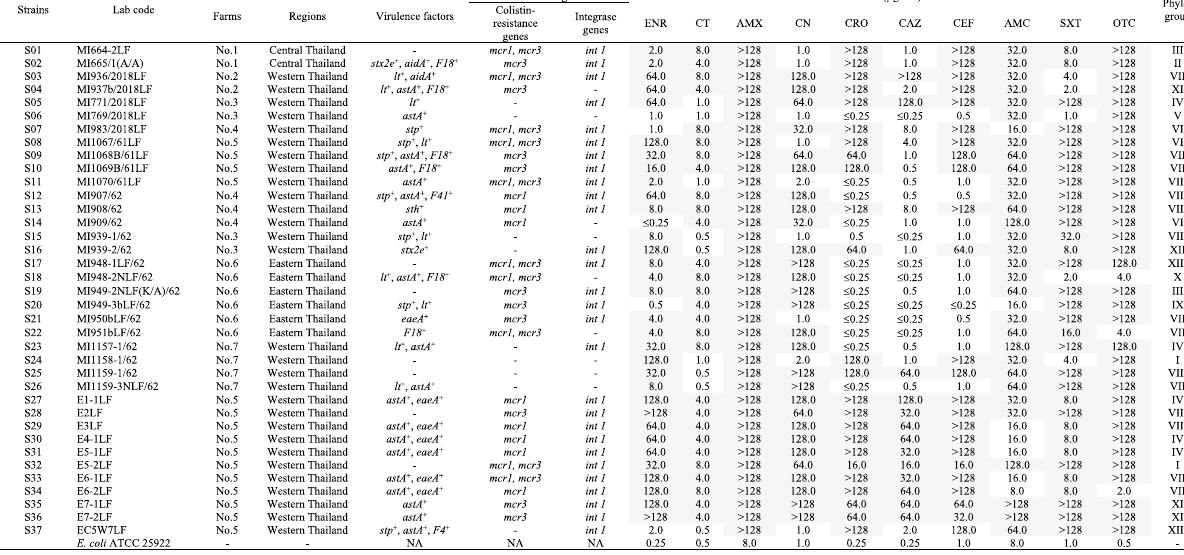
Table 1. Characteristics and antimicrobial susceptibility against 10 antimicrobial agents of E. coli isolated from the rectal swabs of diarrheic piglets of farms in Thailand during 2018 to 2019. Virulence factors included in this data table: shiga-toxin ( stx2e ), heat-labile enterotoxin ( lt ), heat-stable enterotoxin ( stp, sth ), enteroaggregative E. Coli heat-stable enterotoxin 1 ( astA ), intimin ( eaeA ), adhesin ( aidA ) , fimbriae ( F4 , F18 , F41 ). The values were below or above the dilution range marked with the sign “ ≤ ” or “ > ”. MICs highlighted in light grey represent resistance according to CLSI (VET01S, M100) guidelines. NA means not analyzed. AMX amoxicillin, AMC